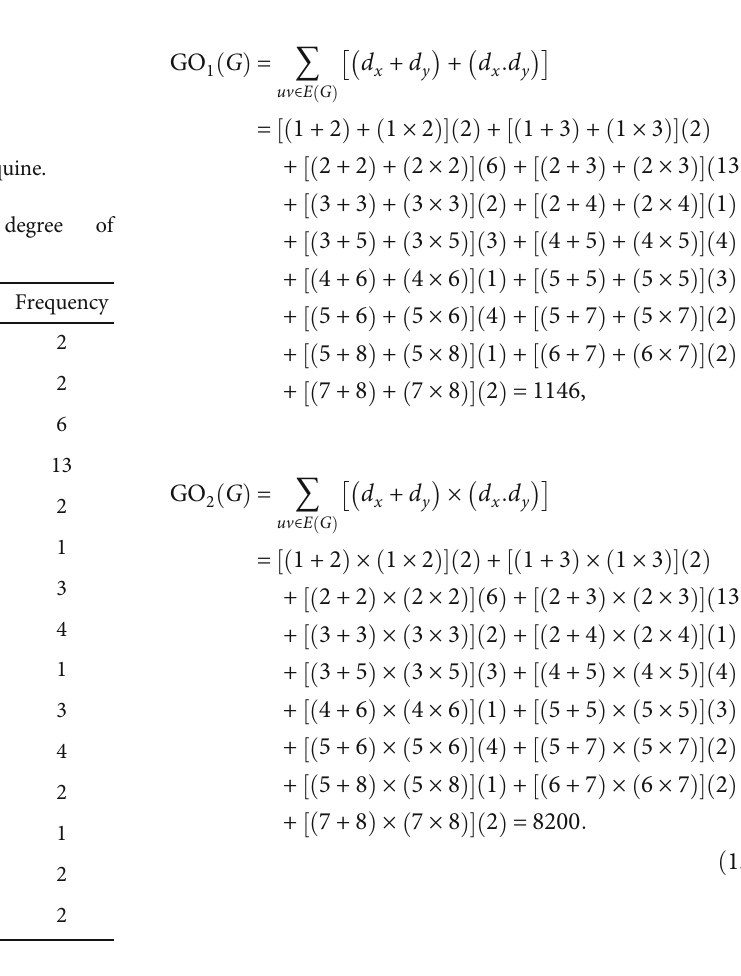
for GO 1 and GO 2 indices: